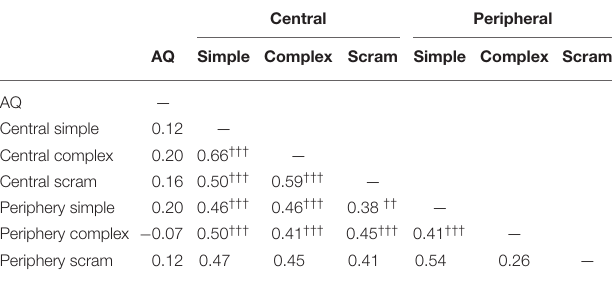
TABLE 4 | Kendall’s Tau correlations for AQ scores and mixed percept